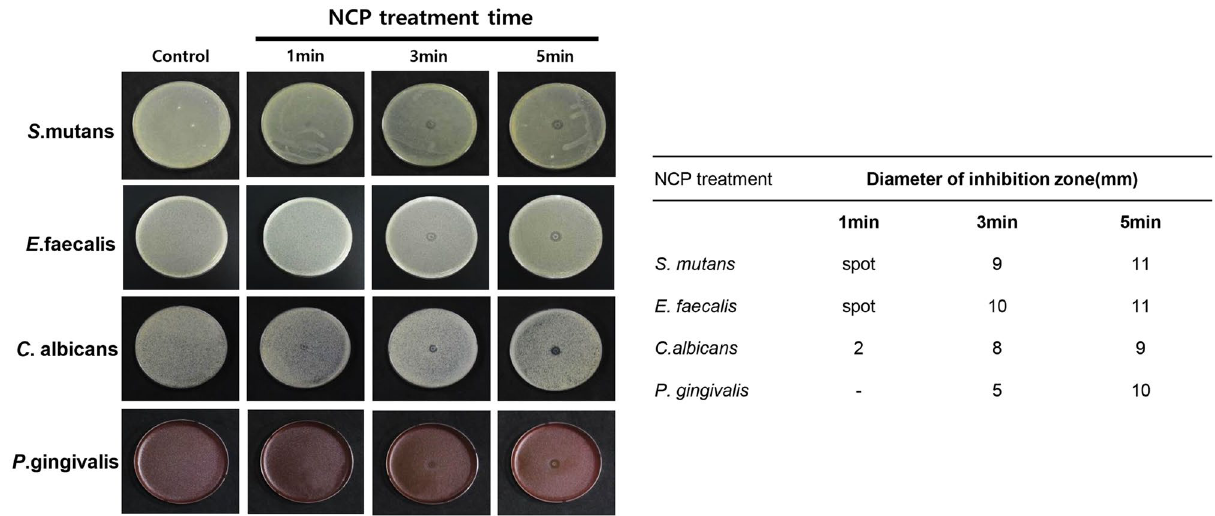
Figure 2. NCP treatment can kill 4 kinds of oral microbes on solid medium. The representative photographs showing the surface bactericidal effect of NCP against S. mutans, E.faecalis, C.albicans and P.gingivalis (left). The photographs were taken at 24 h after the NCP treatment for 1, 3 and 5 min. The distance between the end of NCP device and solid medium inoculated with oral microbes were maintained at 1 cm during the treatment. The diameter of inhibition zone were measured and presented in a table (right).